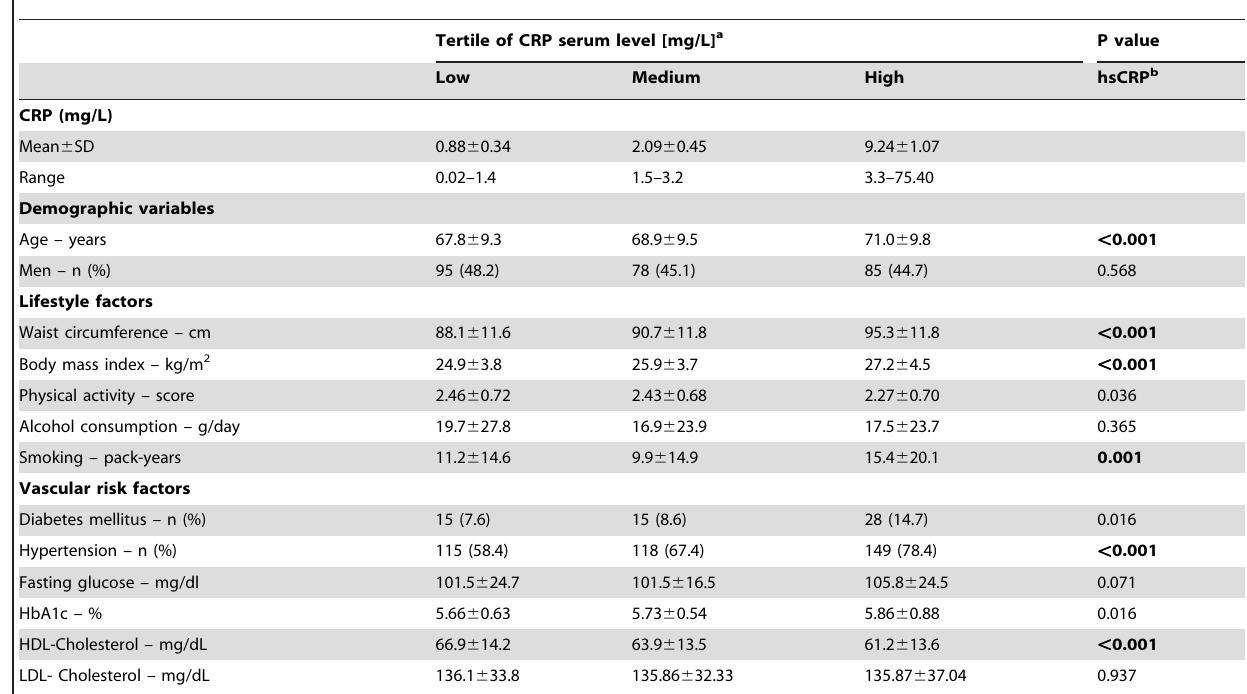
Table 2. Population characteristics according to CRP tertile groups in the Bruneck Study.